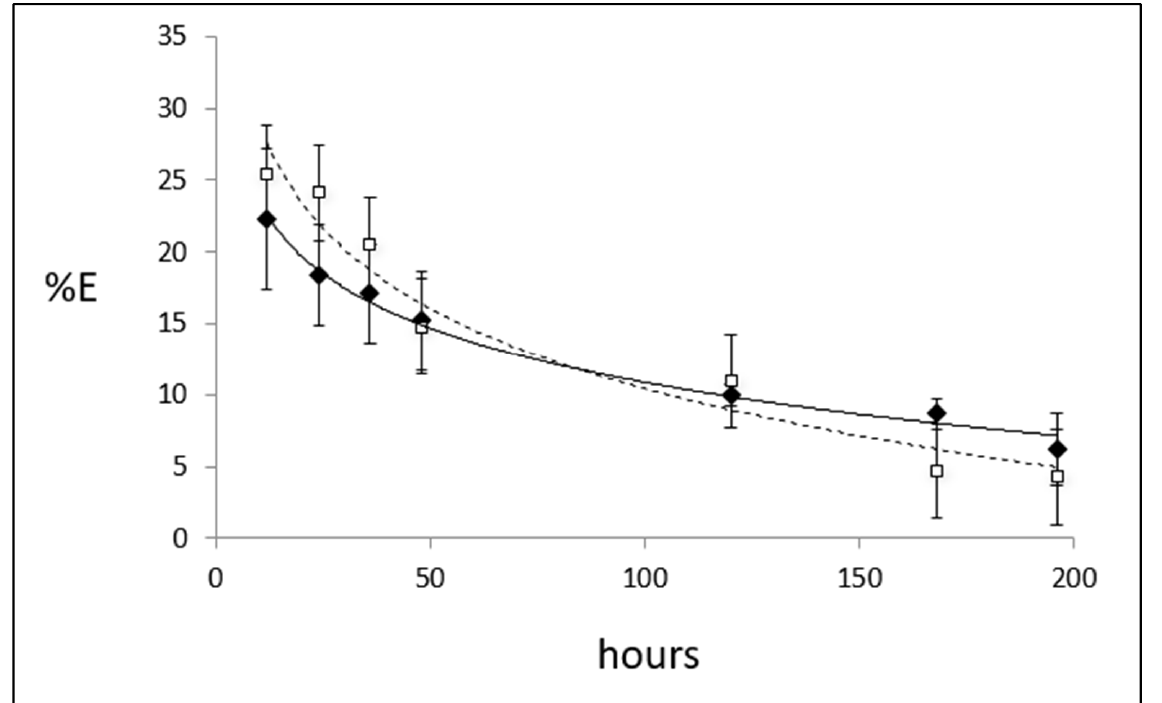
Figure 1. Kinetic of isotopic Zn enrichment in urine and plasma. This figure represents the kinetic from baseline up to 196 h of the Zn isotopic enrichment (%E) measured in plasma (white squares, dashed line) and urine (black squares, continuous line) samples after the administration of 2 mg of 70 ZnSO 4 from eight healthy volunteers. %E in the urine and plasma was calculated as: %E 70 Zn = (( 70 Zn/ 66 Zn) enr − ( 70 Zn/ 66 Zn) base ) × %NA 66 Zn, where %NA 66 Zn is the natural percentage of isotopic abundance of 66 Zn (27.90%). No significant differences related to Zn %E were observed between urine and plasma samples.